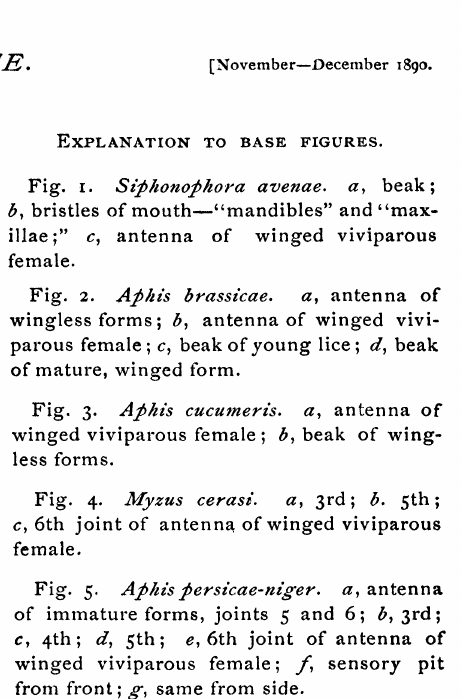
Fig. 5. AibMspersicae’nier" a,